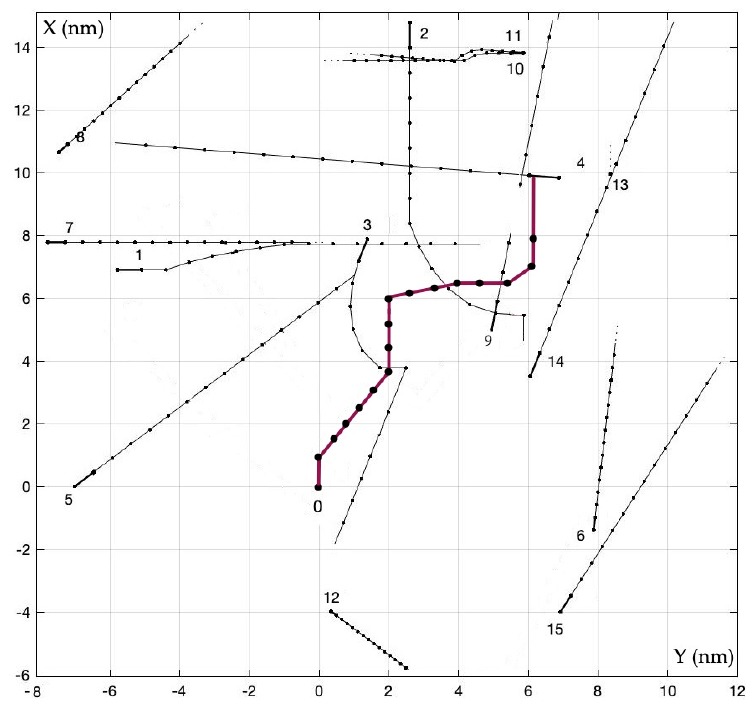
Figure 11. Trajectories of ships in non ‐ cooperative matrix game ANCRGC.